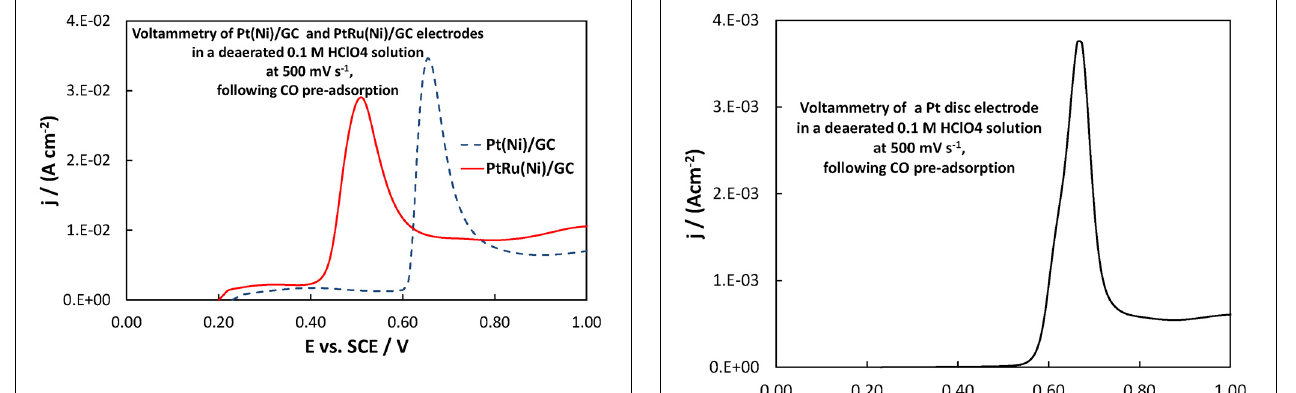
FIGURE 10 | Voltammograms of PtRu(Ni)/GC and Pt(Ni) electrodes in a deaerated 0.1M HClO 4 solution at 500mV s − 1 , following the procedure for CO monolayer adsorption and subsequent oxidation described in section Electrochemical characterization of coatings. The scan initiated at + 0.20V toward more positive potentials.